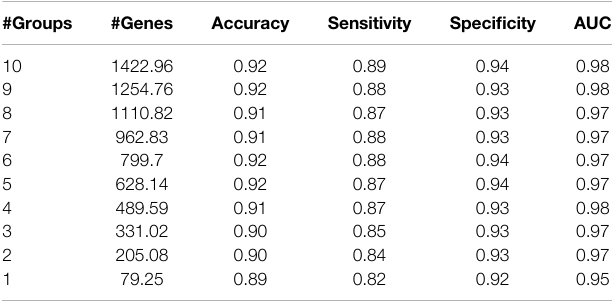
TABLE 4 | An example performance table of miRModuleNet for top ranked 10 modules for BLCA dataset.